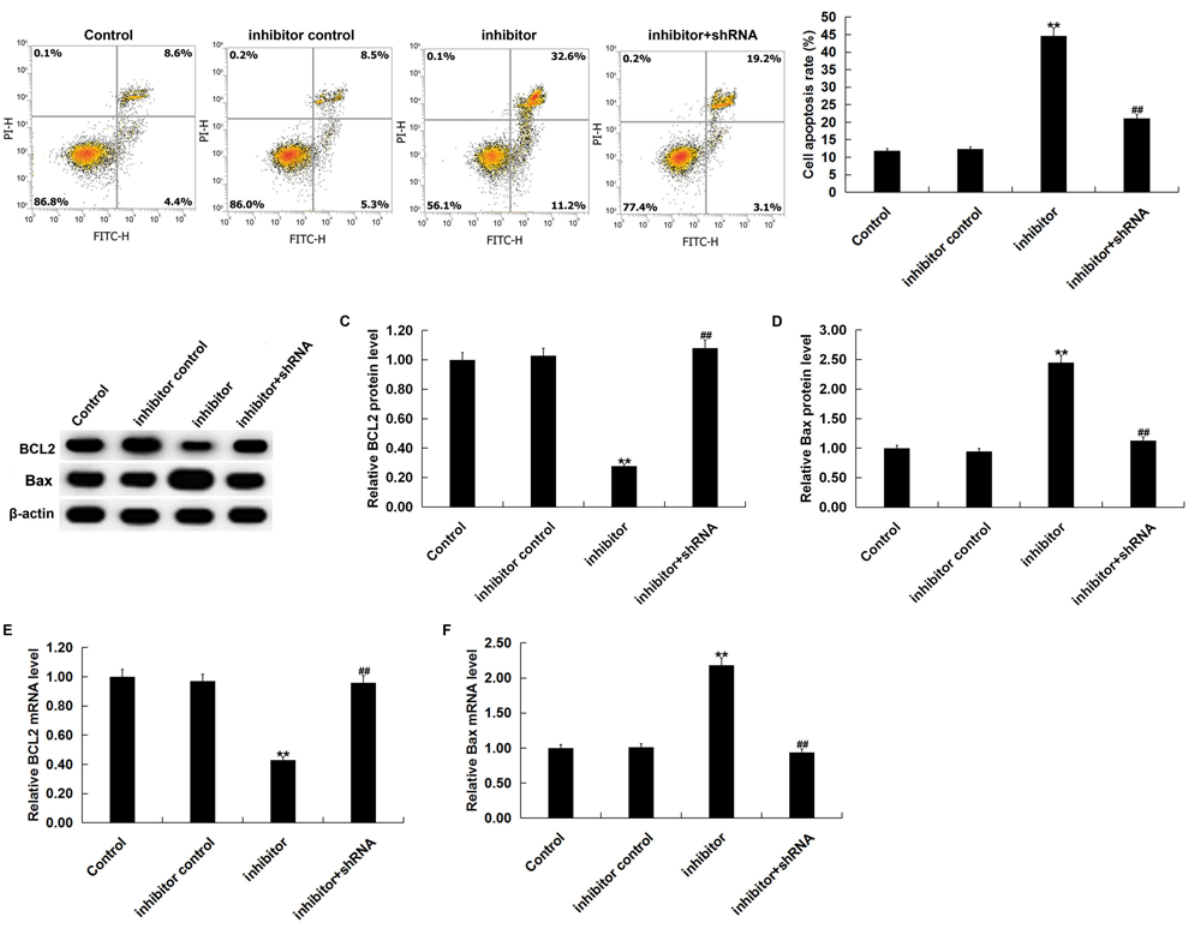
Figure 6: miR-663b inhibitor induced Jurkat cell apoptosis, decreased Bcl-2 expression and increased Bax expression. Jurkat cells were transfected with inhibitor control, miR-663b inhibitor or miR-663b inhibitor+CD99-shRNA for 48 h. (A) Flow cytometry analysis analyzed the percent of apoptotic cells Jurkat cells. (B-D) Western blot assay detected BCL2 and Bax protein expression. (E and F) qRT-PCR detected BCL2 and Bax mRNA expression. The data were expressed as the mean ± SD. **p<00.01 vs. Control; ##p<00.01 vs. inhibitor.